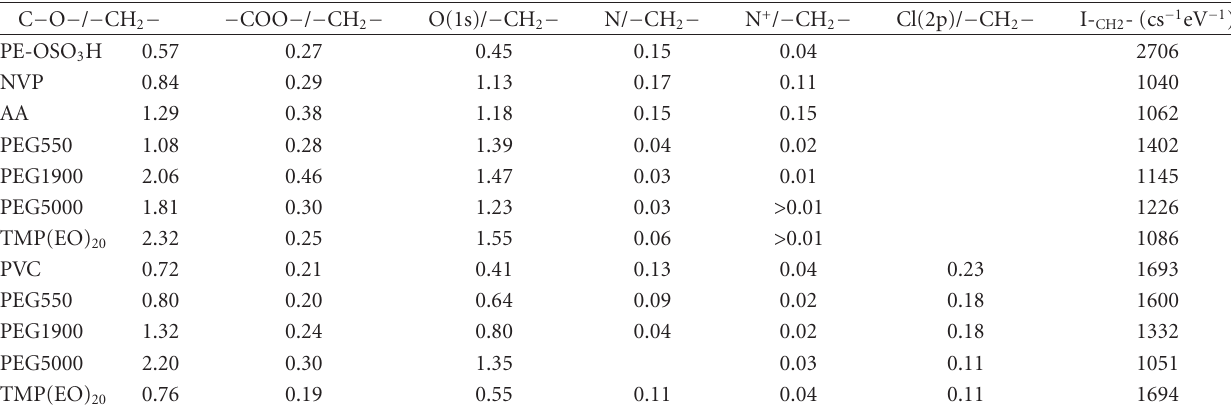
Table 1: Cross-section corrected intensities of characteristic functional groups for various hydrophilic photo-polymeric films: N- vinylpyrrolidone (NVP), acrylic acid (AA) or polyethylene glycol mono-acrylates (PEG) on PE-OSO 3 H and PVC after adsorption of bovine serum albumin (BSA).